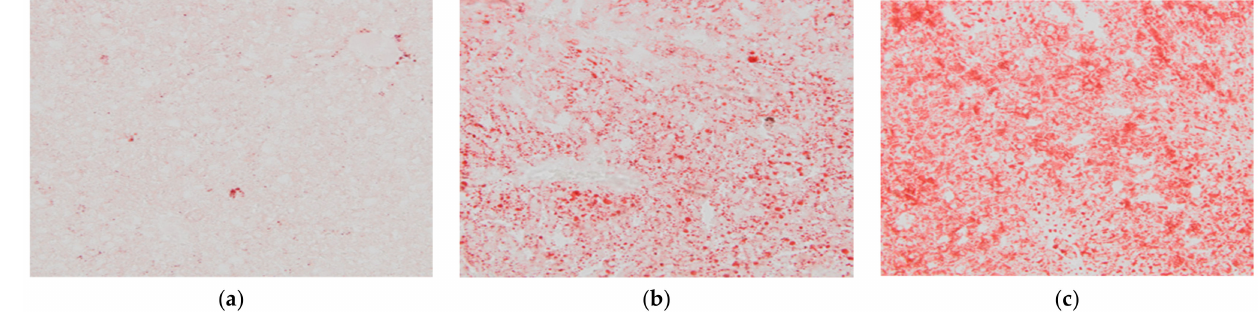
Figure 5. Histological appearance of liver of: ( a ) AIN ch , ( b ) WD ch ( c ) LCHP ch rats (200 × ) stained with ORO.